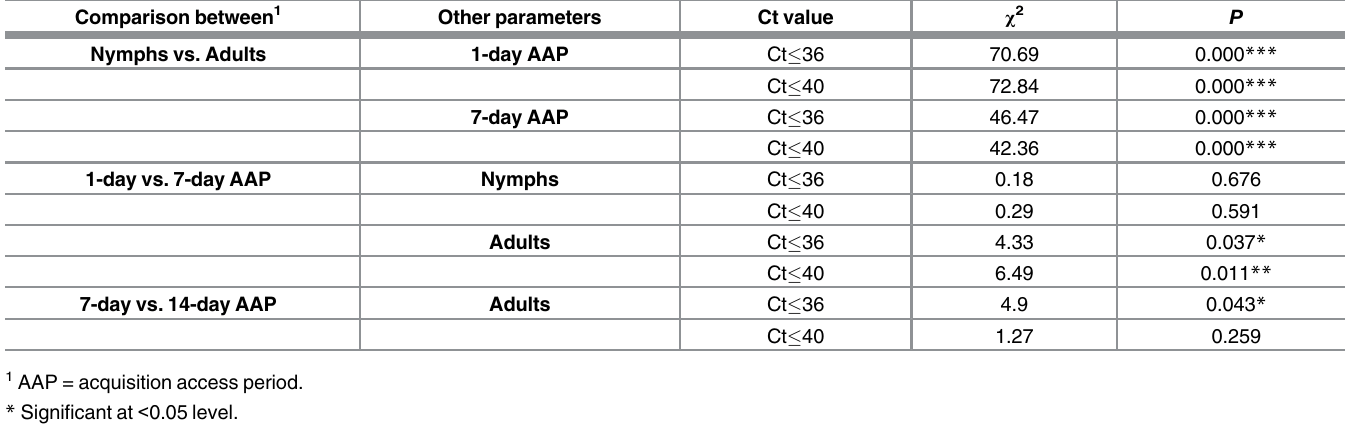
Table 3. χ 2 analysis of Las acquisition results (data in Table